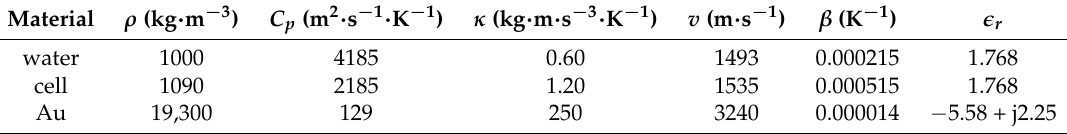
Table 1. Values of the parameters for the photothermal model for the three media (water, cell, gold) and j 2 = −